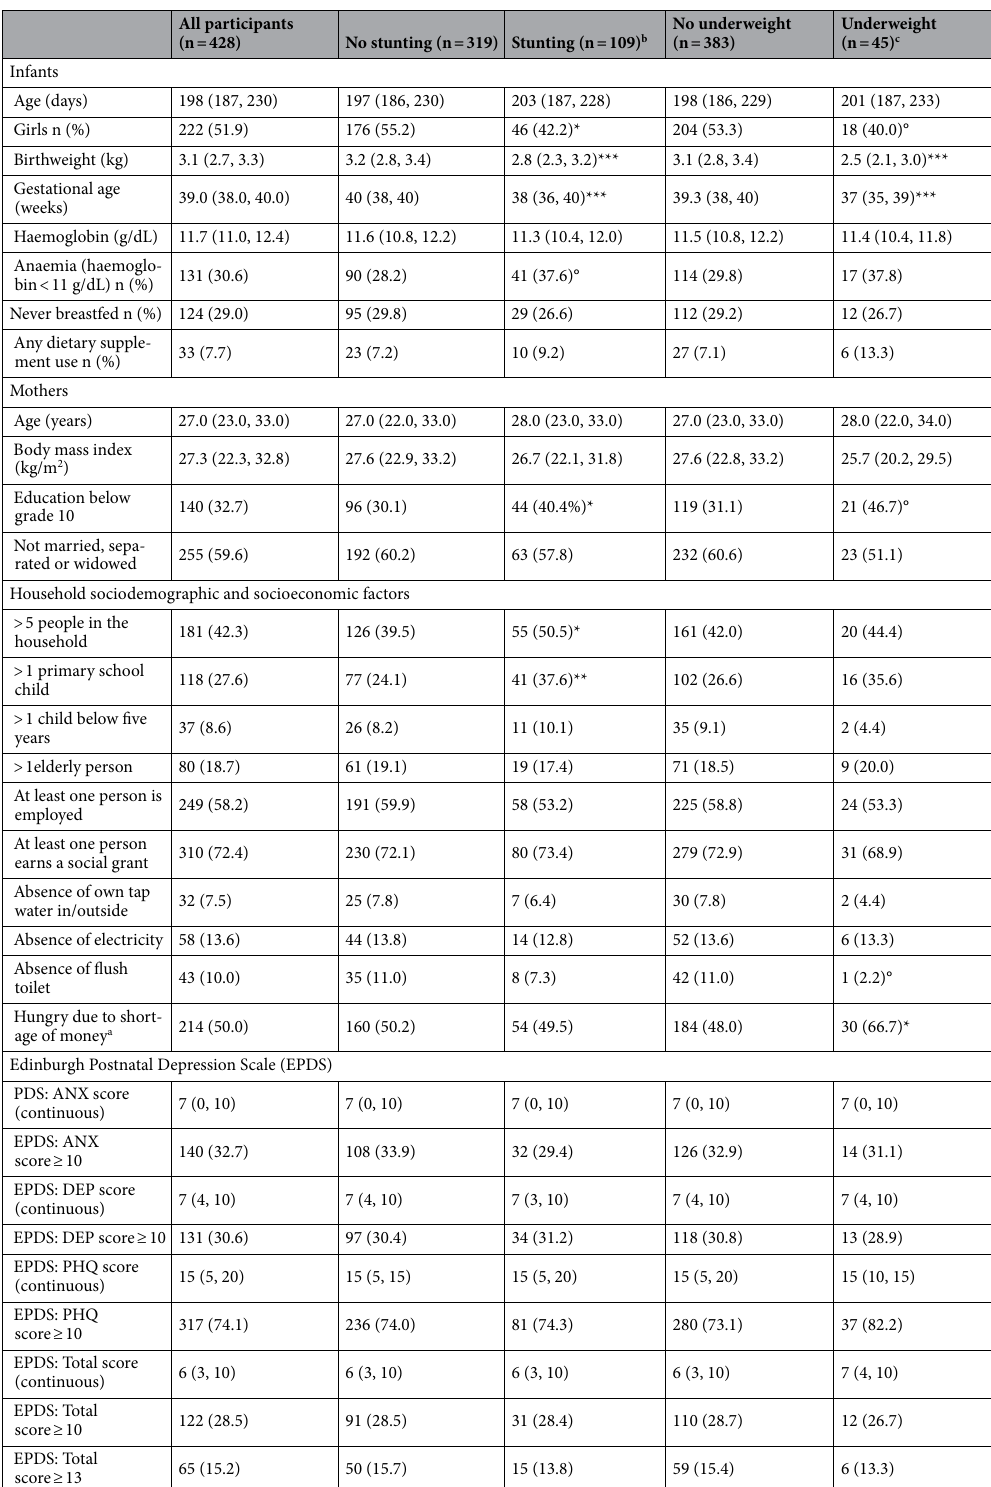
Table 1. Characteristics of infants, mothers, and households Chi-square and independent sample t-test were performed using categorical and continuous variables between stunting and underweight infants versus their healthy counterparts, a in the past week, b stunting defined as length-for-age Z-score < − 2; c underweight defined as weight-for-age Z-score < − 2. Comparison of the rates of positive answers to EPDS to stunting and underweight children vs. their healthy counterparts ***p < 0.001, **p < 0.01, *p < 0.05, °p <